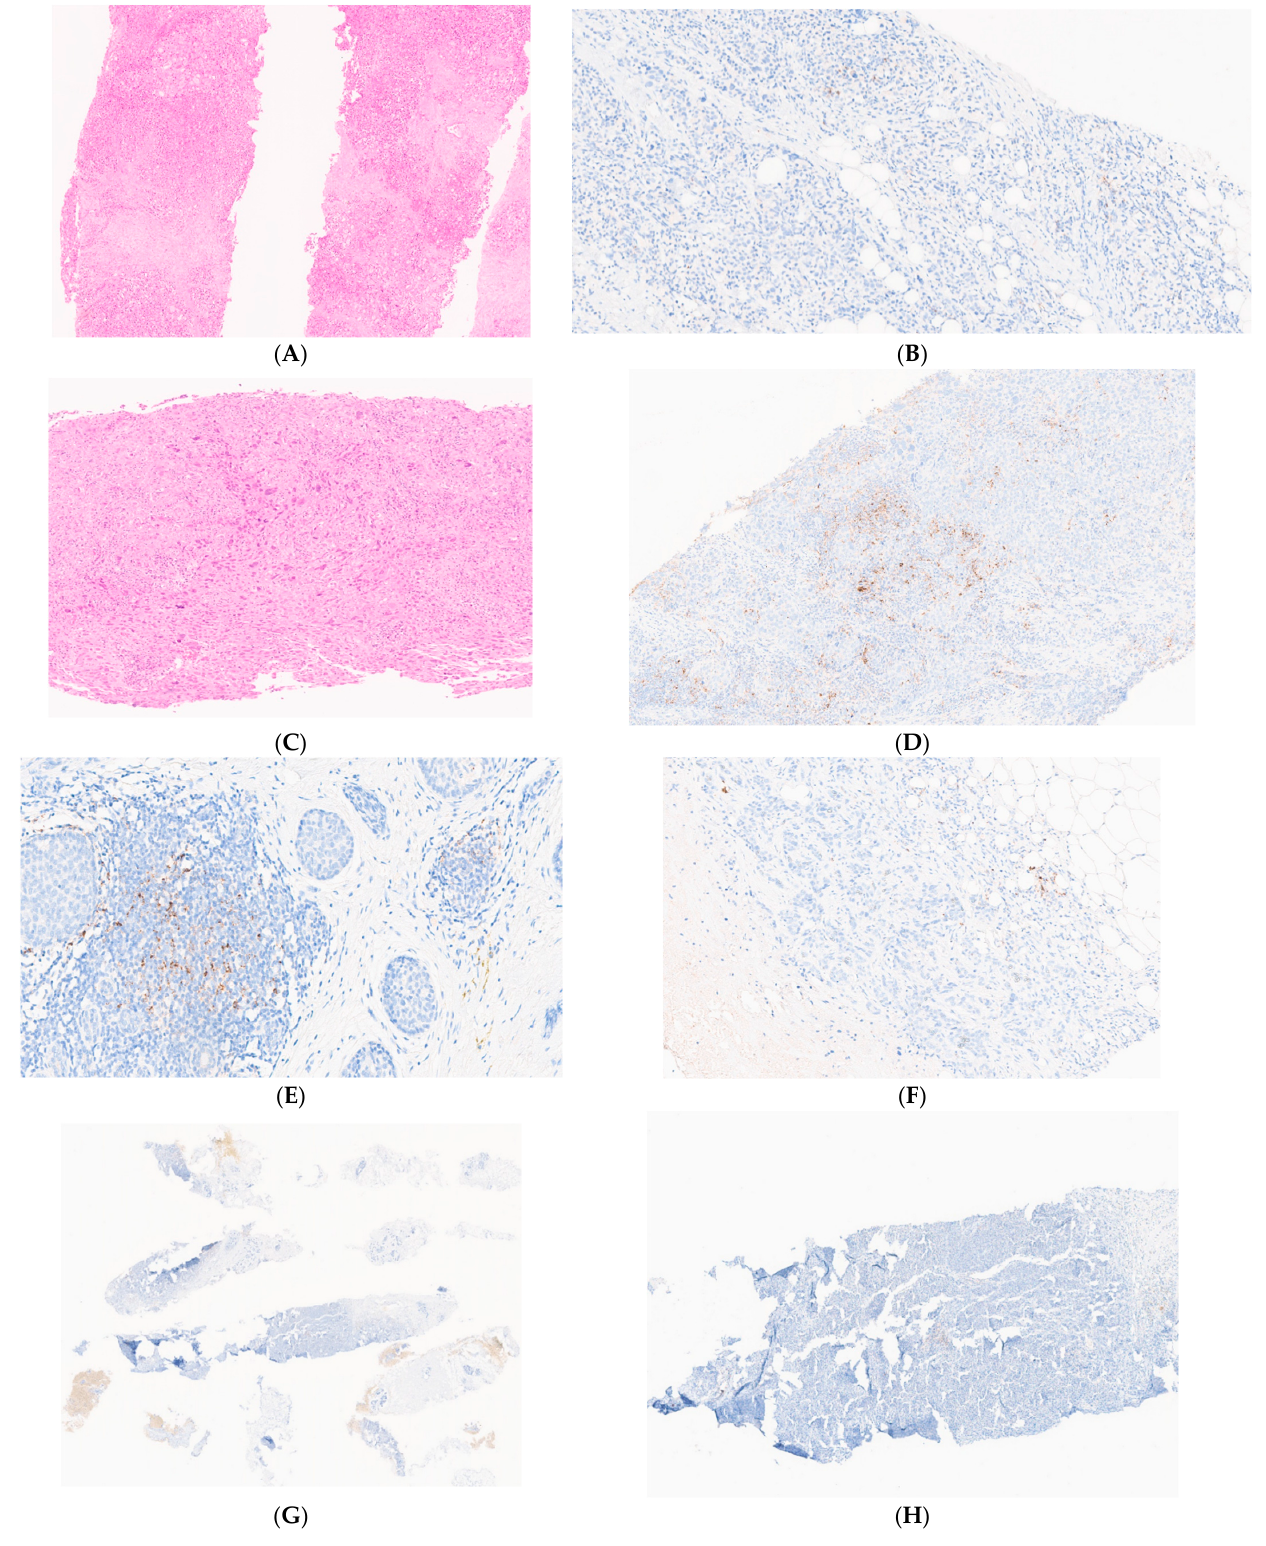
Figure 2. Examples of breast cancer PD-L1 scores using the Ventana SP142 assay and challenging cases: ( A ) H&E staining of three cores of invasive no-special-type carcinoma (×50); ( B ) Only focal PD-L1 staining is noted (<1%), and the case was classified as PD-L- negative (×100); ( C ) H&E staining